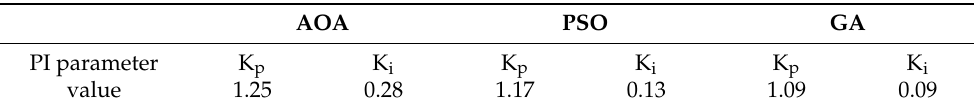
Table 6. Optimized PI Parameters for L-L-G scenario. AOA PSO GA